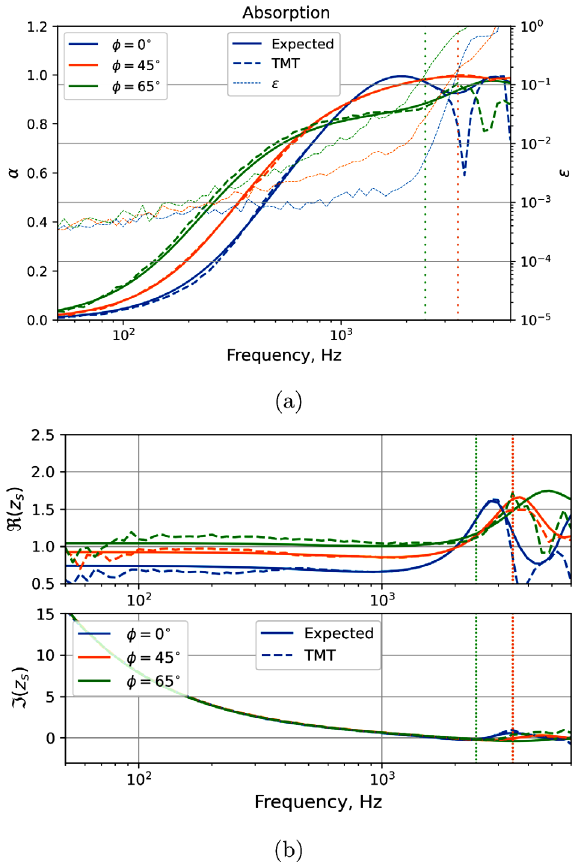
Figure 10. Block diagram of the experimental implementation of the full physical